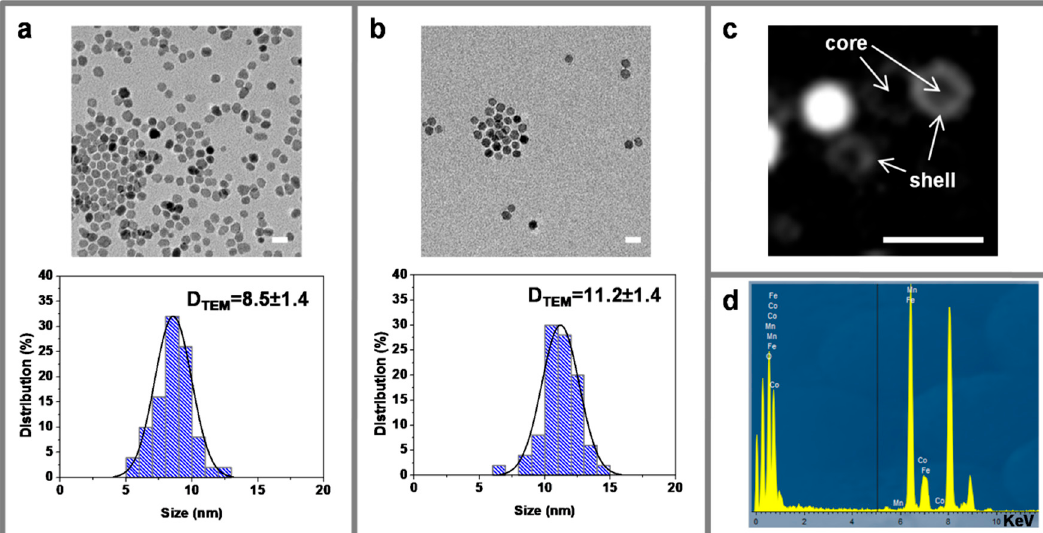
Figure 3. Representative Transmission Electron Miscroscopy (TEM) images (top) of CF ( a ) and CF@MF ( b ) NPs, and their corresponding size distribution histograms (bottom). TEM diameters are expressed as the mean ± SD by measuring at least 100 particles. Representative Dark field-TEM images of CF@MF NPs ( c ). Scale bar is equivalent to 20 nm in all images. EDX spectrum of CF@MF nanoparticles ( d ).